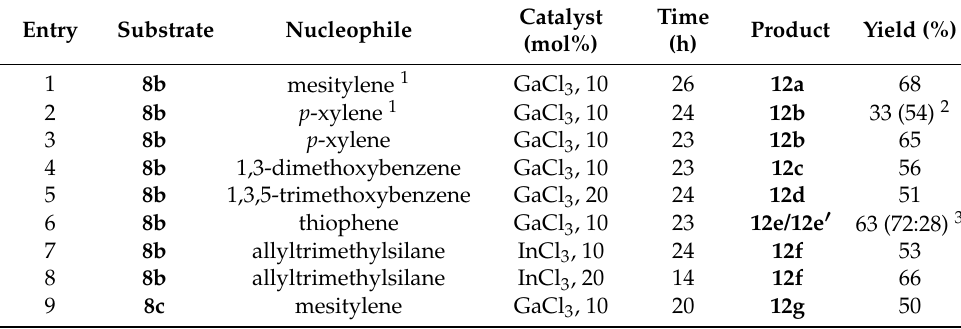
Table 3. Results for condensation reactions of 8b , 8c .